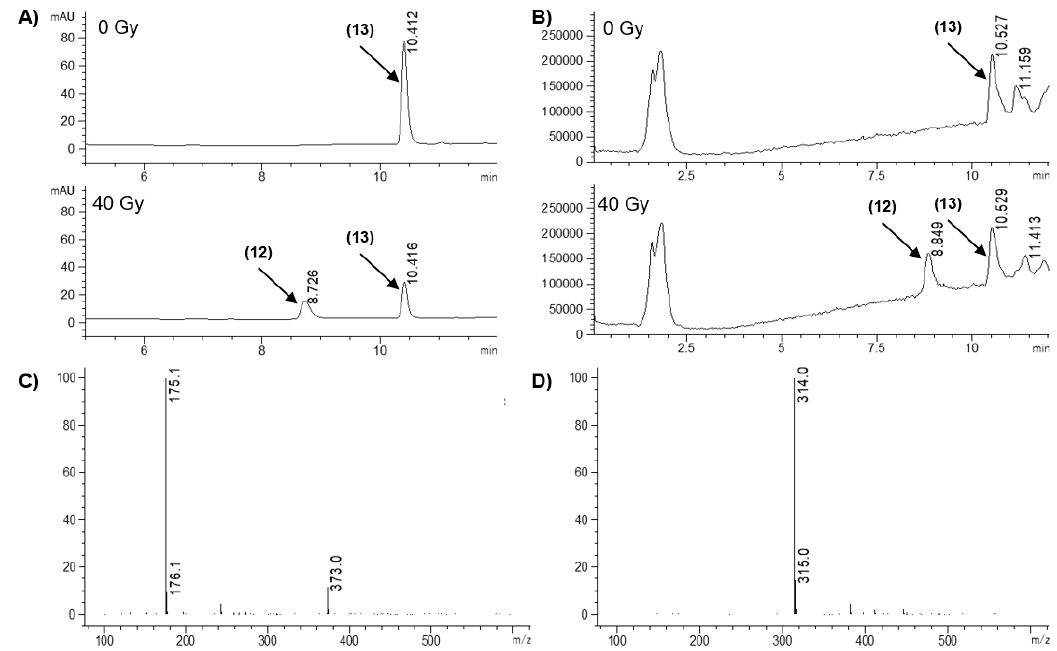
Figure 7. LC / MS analysis of the radiolytic reduction of model HAP 13 . ( A ) Diode array chromatograms Figure 7. LC/MS analysis of the radiolytic reduction of model HAP 13 . A) Diode array chromatograms at 276 nm (bandwidth 16 nm), with 0 and 40 Gy. ( B ) Total ion chromatograms (negative mode, scanning at 276 nm (bandwidth 16 nm), with 0 and 40 Gy. B) Total ion chromatograms (negative mode, m / z 100–600), with 0 and 40 Gy. ( C ) Mass spectrum of peak at 8.849 min (identified as e ff ector by scanning m/z 100–600), with 0 and 40 Gy. C) Mass spectrum of peak at 8.849 min (identified as effector comparison with authentic 12 ). ( D ) Mass spectrum of peak at 10.529 min (identified as prodrug by by comparison with authentic 12 ). D) Mass spectrum of peak at 10.529 min (identified as prodrug by comparison with authentic compound 13 comparison with authentic compound 13 ).